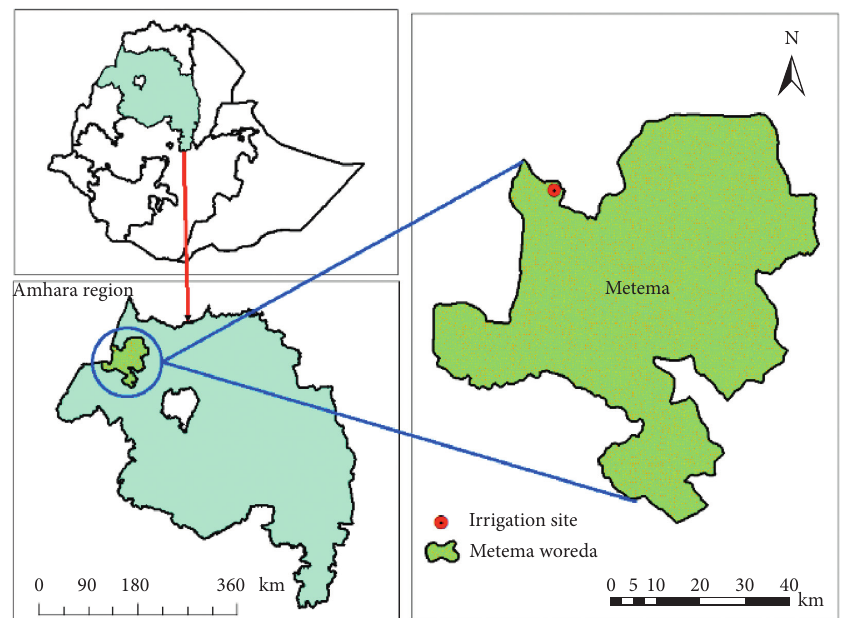
Figure 1: The geographic map of Metema Experiential Site, North Western low land of Ethiopia.